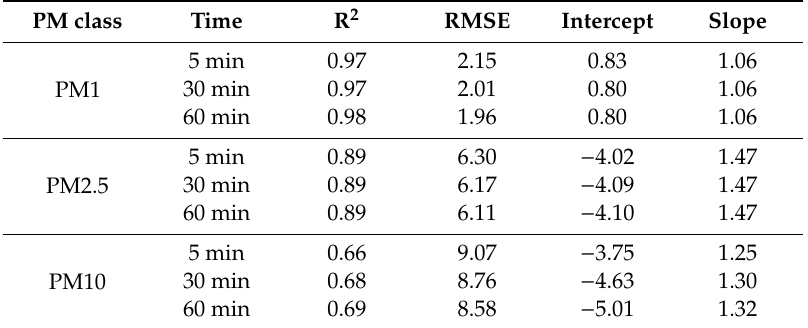
Figure 1. Correlation plots from collocating the portable Arduino based low-cost particulate matter (PM) measuring (PPM) unit with GRIMM. Rows present di ff erent sizes of particulate matter (PM 1 ( a – c ), PM 2.5 ( d – f ), PM 10 ( g – i )) and columns di ff erent time intervals (5 min ( a , d , g ), 30 min ( b , e , h ), 60 min ( c , f , i )). Table 3. Relationship between portable Arduino based low-cost particulate matter (PM) measuring (PPM) unit and GRIMM. RMSE, root mean square